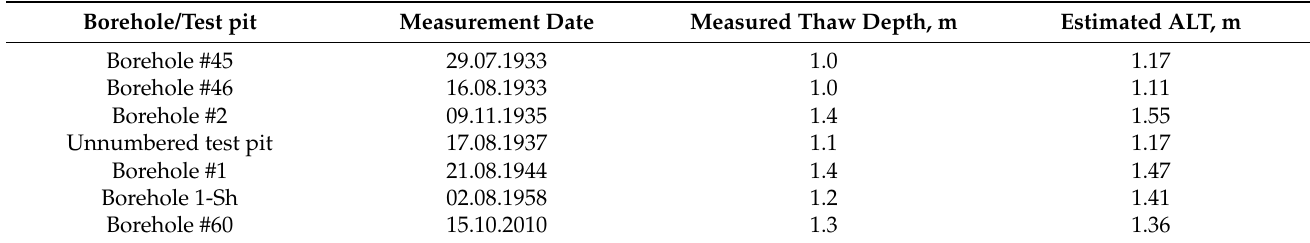
Table 8. Active layer thickness in anthropogenic sediments based on drilling